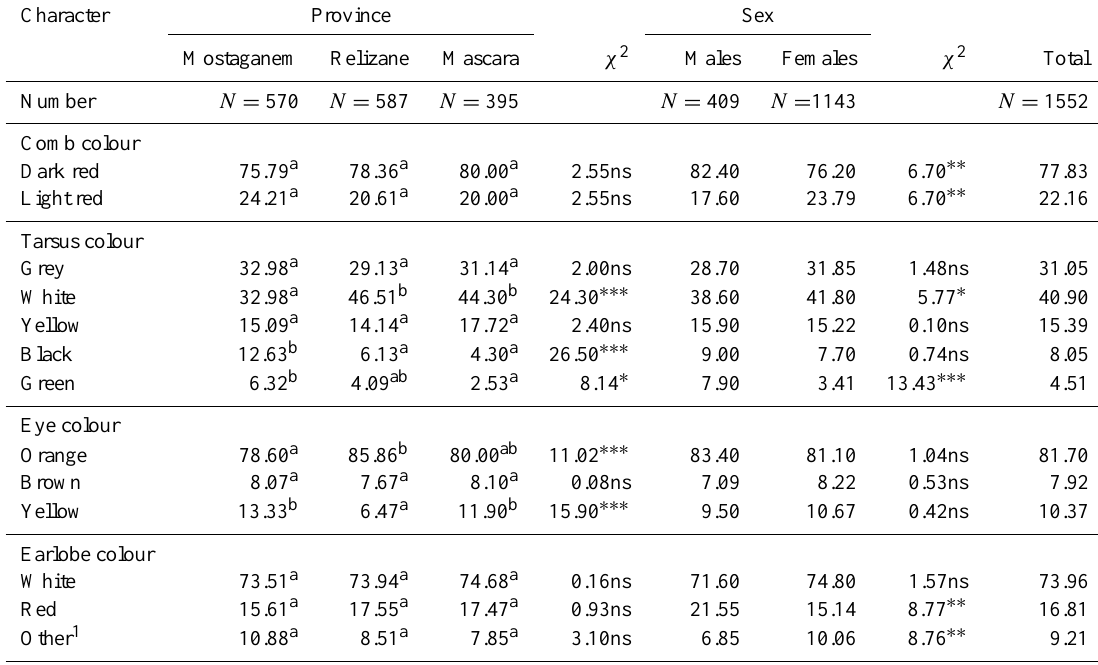
Table 1. Occurrence (%) of comb colour, tarsus colour, eye colour, and earlobe colour of 1552 local chickens from the northwest of Algeria summarized by province and by